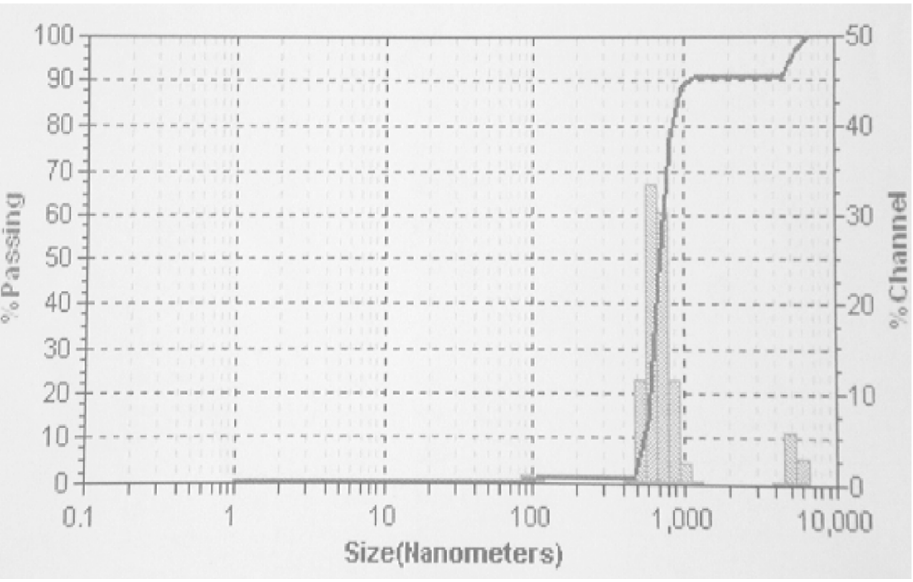
Figure 4. Particle size distribution of IONPs by diffraction light scattering (DLS, digital image).